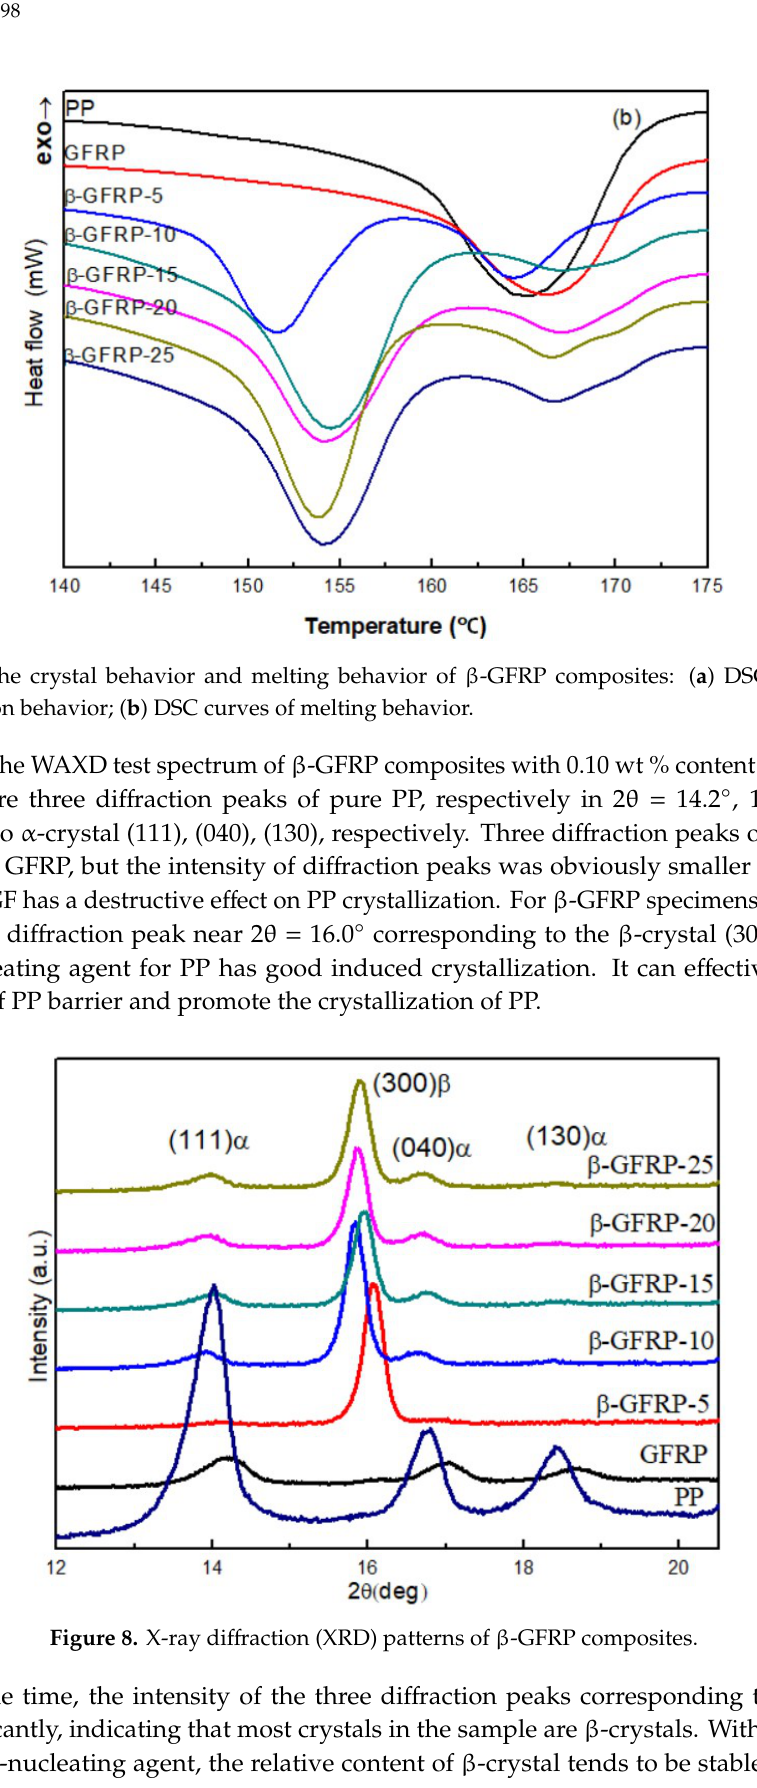
Figure 7. The crystal behavior and melting behavior of β-GFRP composites: ( a ) DSC curves of crystallization behavior; ( b ) DSC curves of melting behavior.